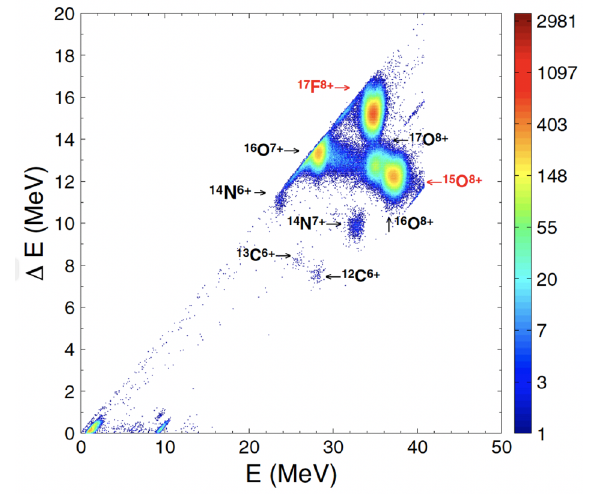
Figure 2. ∆ E-E plot for 17 F production, showing a 0.24% con- tamination of 15 O.